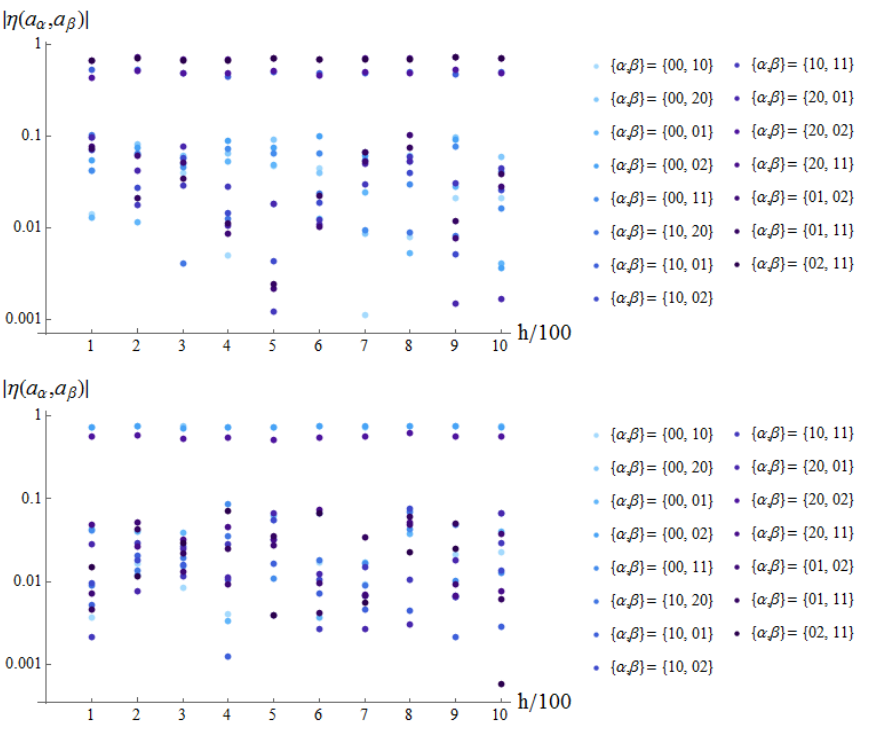
Figure 4 . The absolute value of (linear) correlations between Taylor series coe(cid:14)cients. We consider the sigmoid activation (upper) and the sine activation (lower) respectively. The data is constructed via x 0 = y 0 = 1, (cid:11) = 100, (cid:12) = 100, w = 1 =h and h changes from 100 to 1000, and we realize the network for 1000